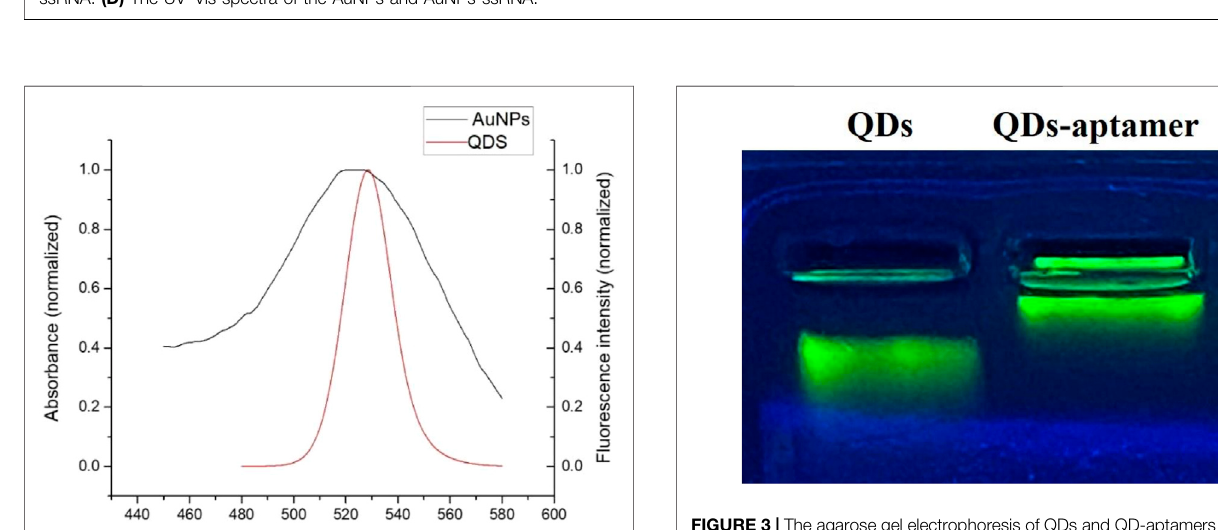
FIGURE 1 | (A) The hydrodynamic size distribution of AuNPs by DLS measurement. (B) TEM image of AuNPs. (C) The zeta potentials of AuNPs and AuNPs- ssRNA. (D) The UV – Vis spectra of the AuNPs and AuNPs-ssRNA.